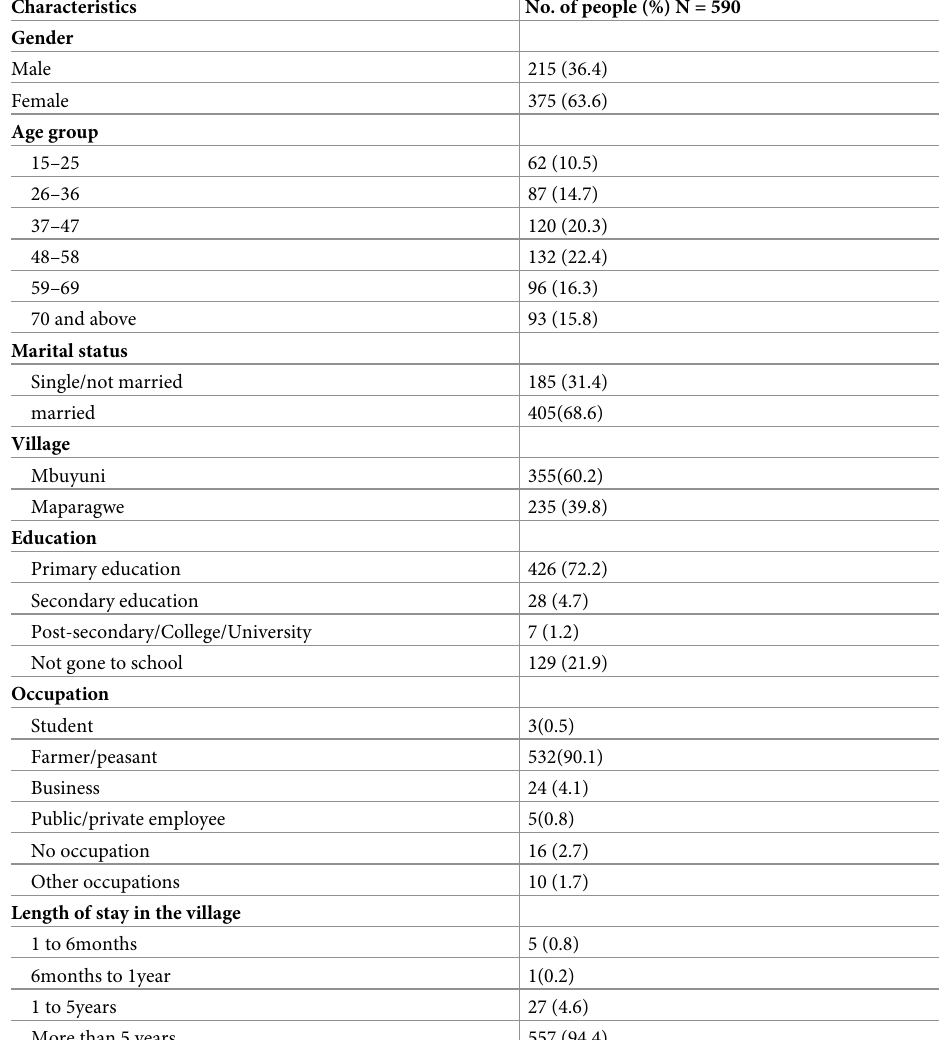
Table 1. Social demographic characteristics of the study participants.